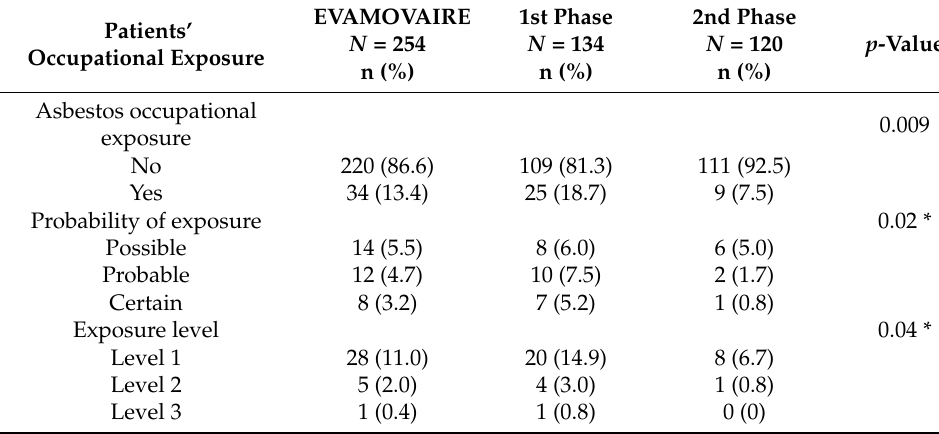
Table 3. Estimation of patients’ occupational exposure.